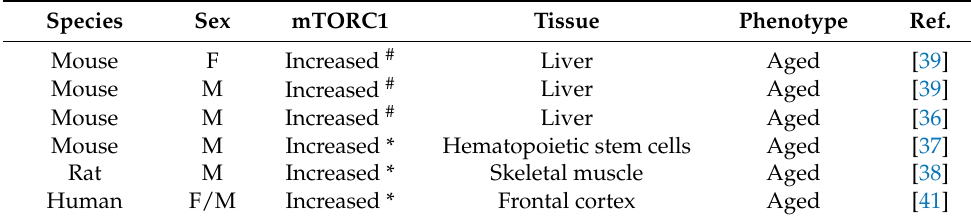
Table 3. Age-related changes in mTOR signalling. Increased or reduced mTOR content can refer to either transcript content, gene expression, protein content, protein phosphorylation or activity after insulin stimulation. Letters refer to: female (f); male (m). Symbols refer to: * Studies in which the expression, content or phosphorylation of mTORC1 itself were evaluated; # Studies in which mTORC1 itself wasn’t been evaluated, but its upstream or downstream effectors